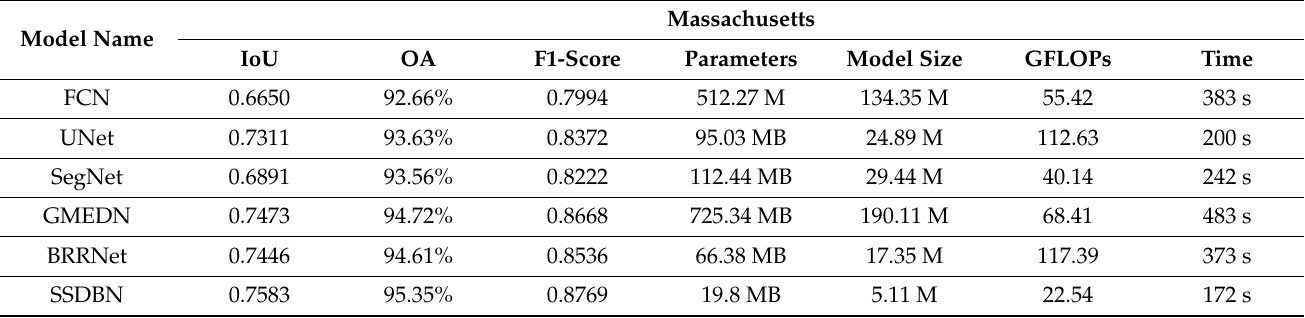
Table 1. Comparison of different models with the Massachusetts Building